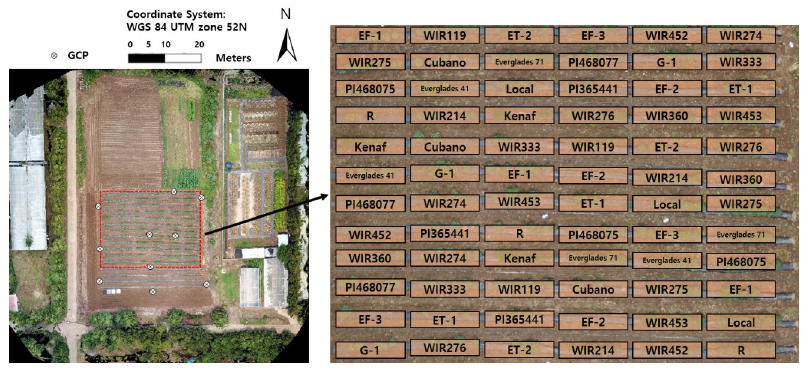
Fig 1. Experimental plots and total cultivars of kenaf used in this study.